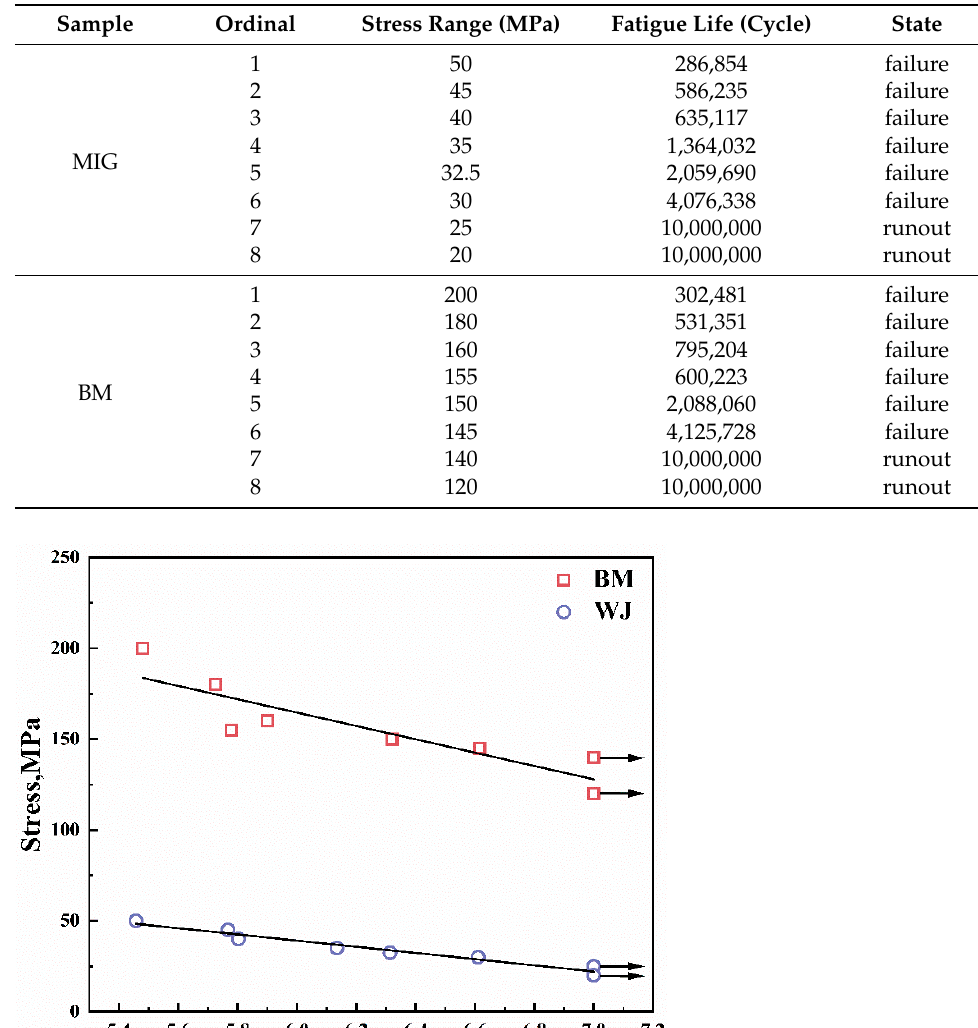
Table 3. Fatigue data table of MIG and BM 6005A-T6 aluminum alloy. Figure 4. ( a ) The hardness value distribution of line 1 and line 2 in Figure 1; ( b ) Hardness value distribution diagram of line 3 in Figure 1.